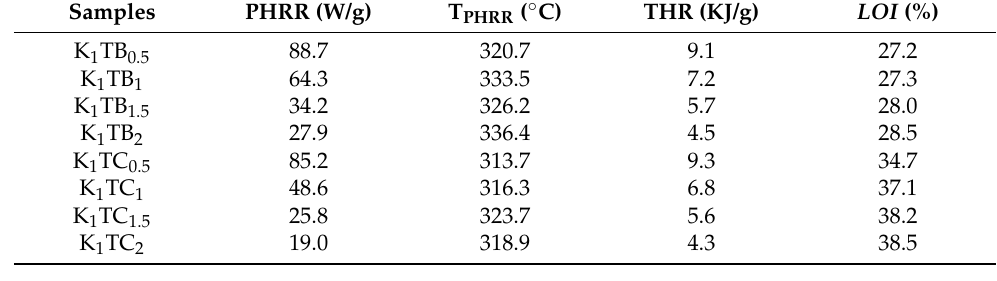
Table 3. The flame retardancy of aerogel samples from limiting oxygen index ( LOI ) and microscale combustion calorimeter (MCC) tests.